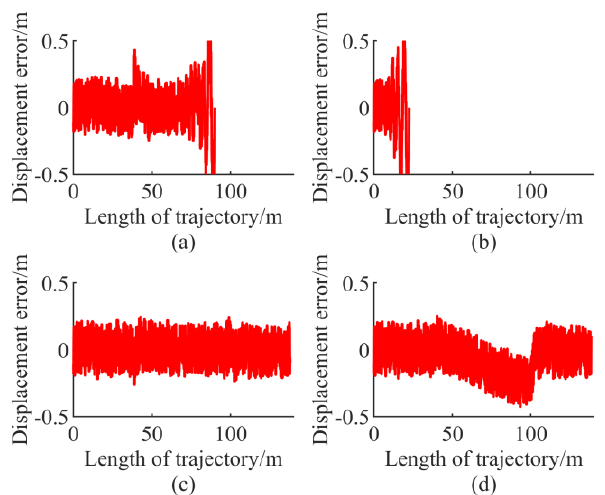
Figure 36. The displacement error with the positioning error in ± 0.2 m. ( a ) LMPC. ( b ) LEMPC. ( c ) NMPC. ( d ) NEMPC. Table 8. The maximum absolute values with the positioning error in ±0.2 m.